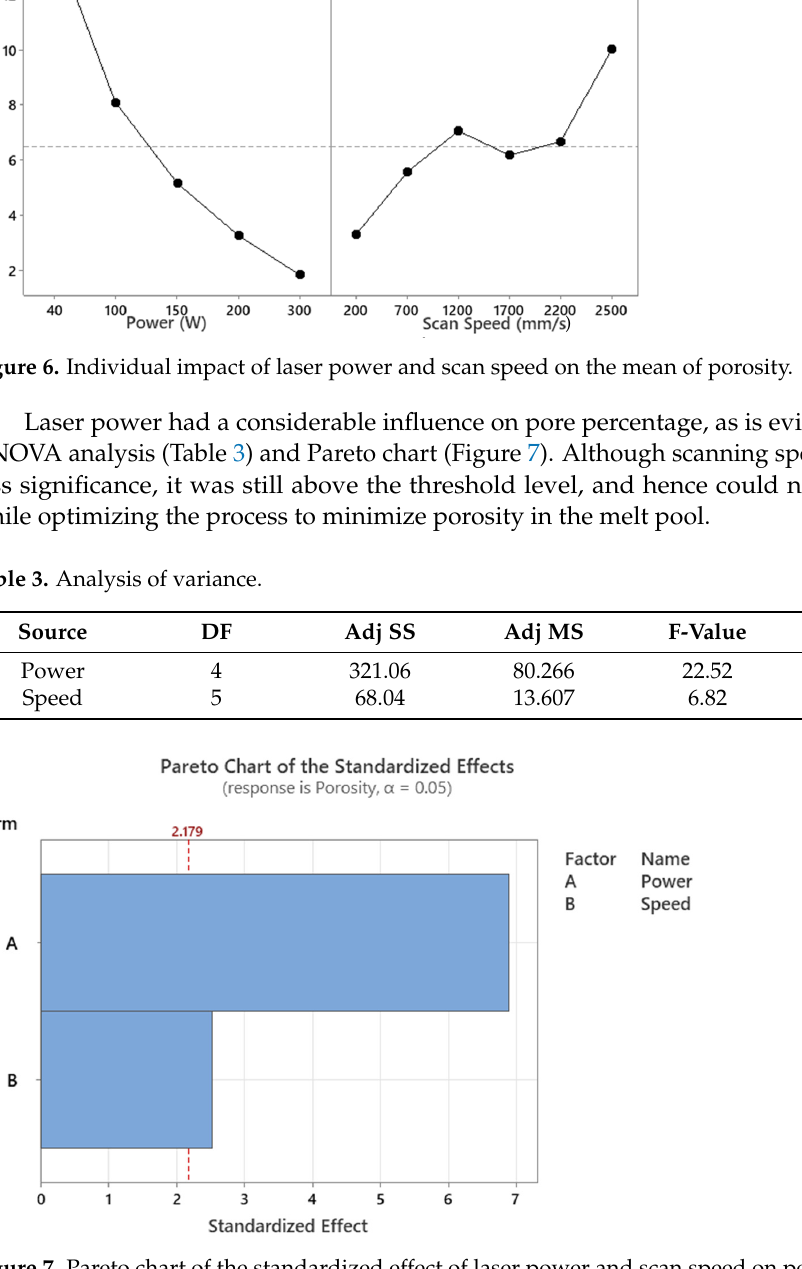
Figure 5. Pareto chart of the standardized effect of laser power and scan speed on contact angle .